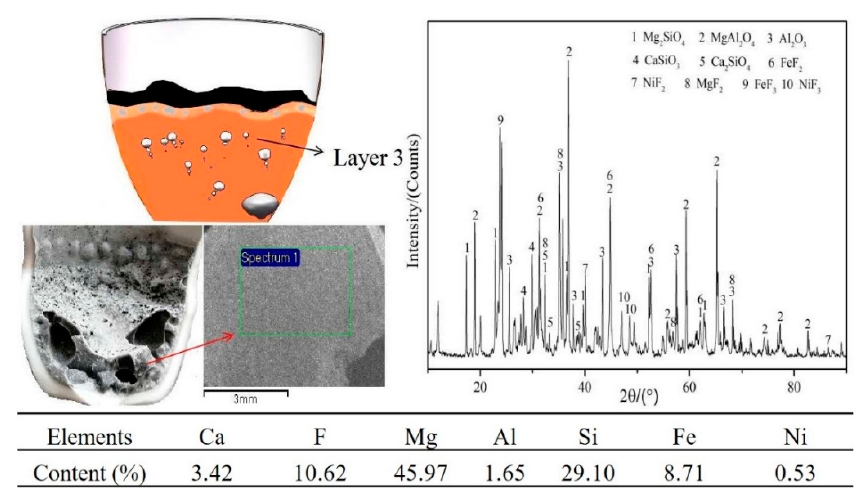
Figure 8. XRD pattern and EDS analysis of Layer 3.